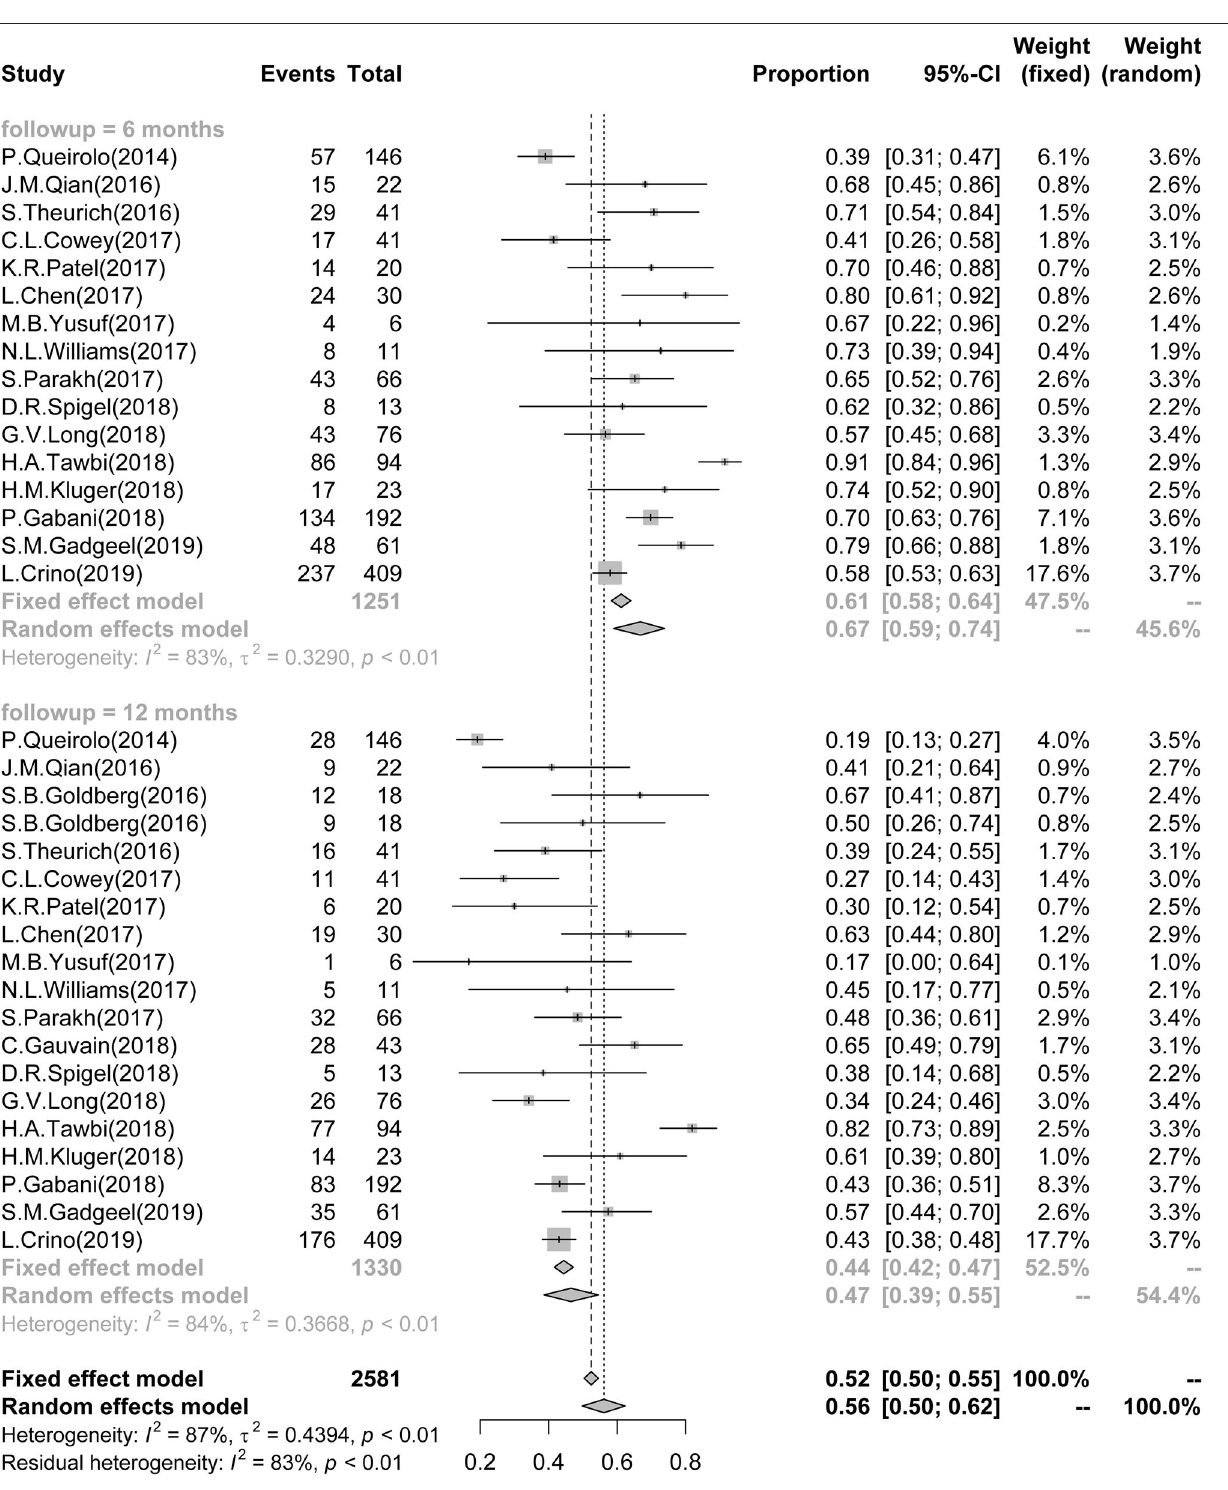
Frontiers in Oncology |